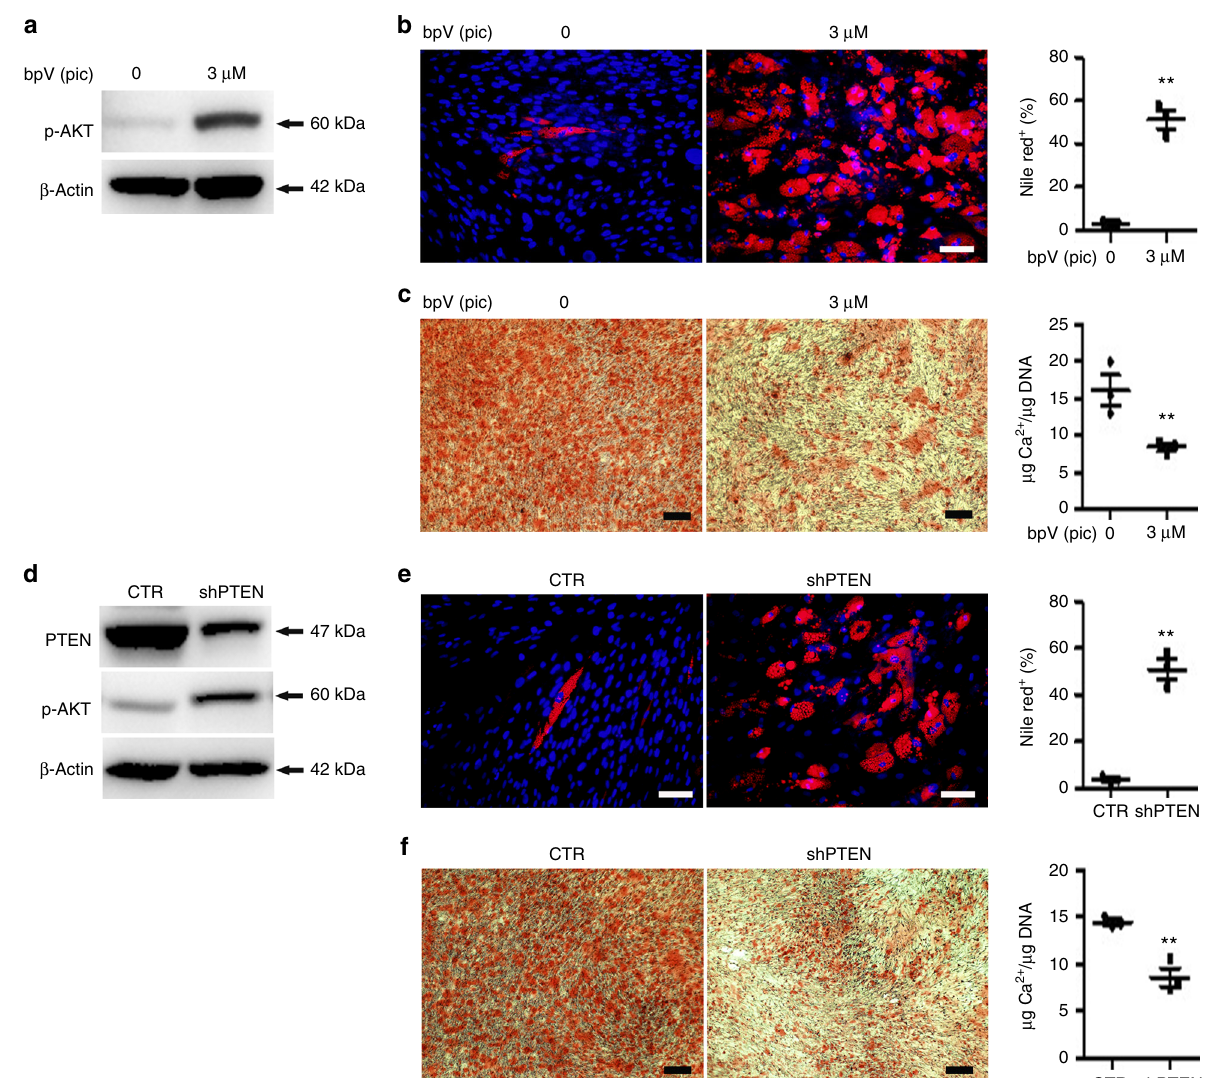
Fig. 3 PTEN inhibition or knockdown increases adipogenesis but decreases osteogenesis in DP-MSCs. a – c DP-MSCs were pretreated without or with PTEN inhibitor, bpV(pic), for 2 h, followed by induction in b adipogenic or c osteogenic induction medium. a Cells in serum-free culture were analyzed by western blotting. Cells were analyzed by b nile red at 3 weeks, and c Arsenazo III at 2 weeks. d – f DP-MSCs without (CTR) or with PTEN knockdown (shPTEN) were induced in e adipogenic or f osteogenic induction medium. d Cells in serum-free culture were analyzed by western blotting. Cells were analyzed by e nile red at 3 weeks and f Arsenazo III at 2 weeks. b , e (right) Nile red positive cell percentages were quanti fi ed. c , f (right) The calcium contents were quanti fi ed relative to DNA contents. Quanti fi cation data are expressed as the mean ± SD of three independent experiments. * p < 0.05; ** p < 0.01 versus bpV(pic) = 0 or CTR determined by Student ’ s t -test. Bar = 50 μ m in nile red staining. Bar = 200 μ m in Arsenazo III